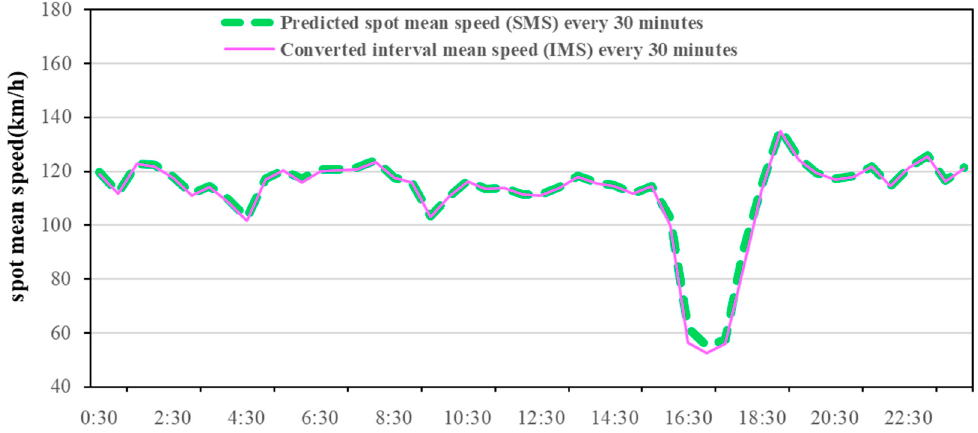
Figure 3. Predicted spot mean speed at (SMS) and converted interval mean speed (IMS) every 30 min.